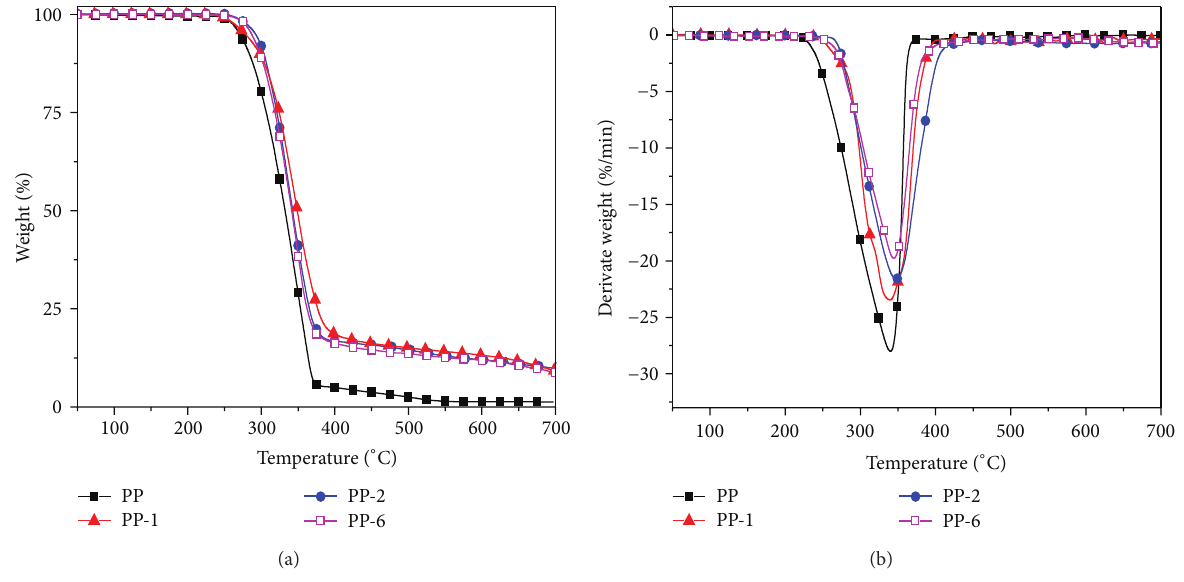
Figure 7: (a) TGA and (b) DTG curves of PP and the flame retardant PP under air atmosphere.